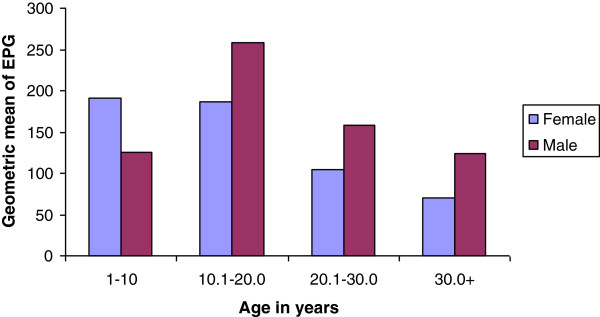
Geometric mean as a measure of intensity of infection of
S. mansoni
by sex, Waja-Timuga, Dec. 2011-Mar. 2012.